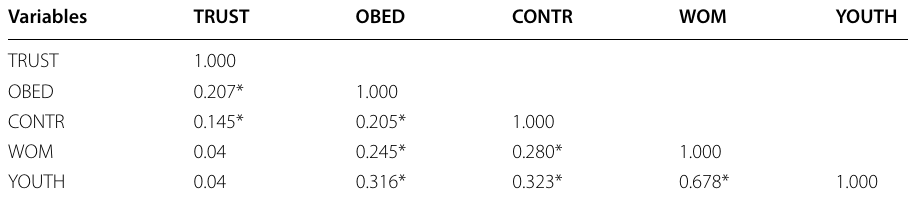
* indicates significance at the 5% level